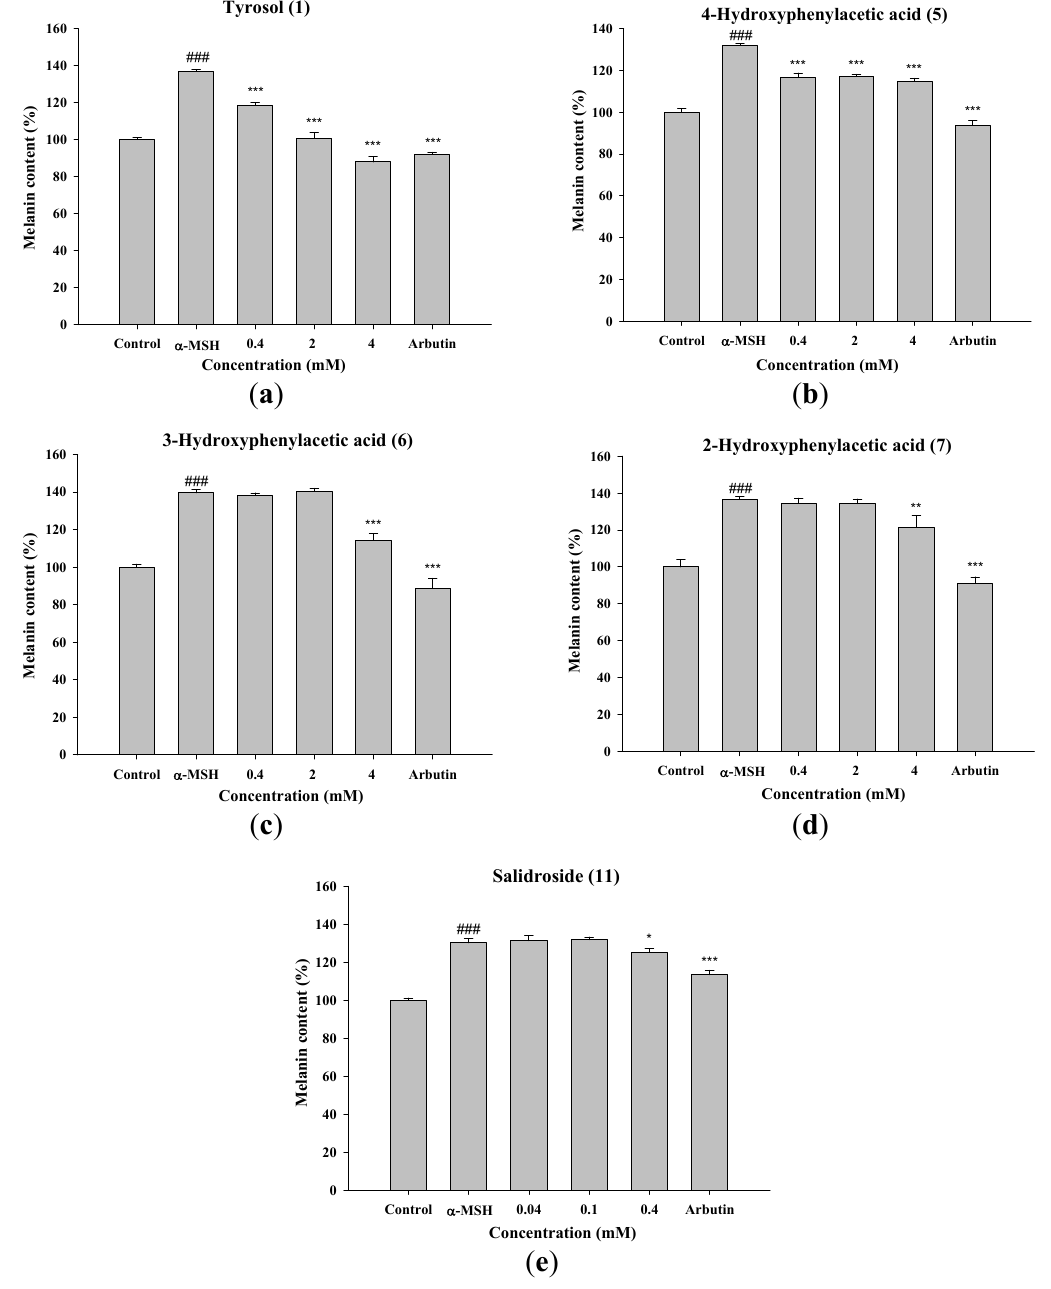
Figure 8. Effects of ( a ) tyrosol ( 1 ); ( b ) 4-hydroxyphenylacetic acid (4-HA) ( 5